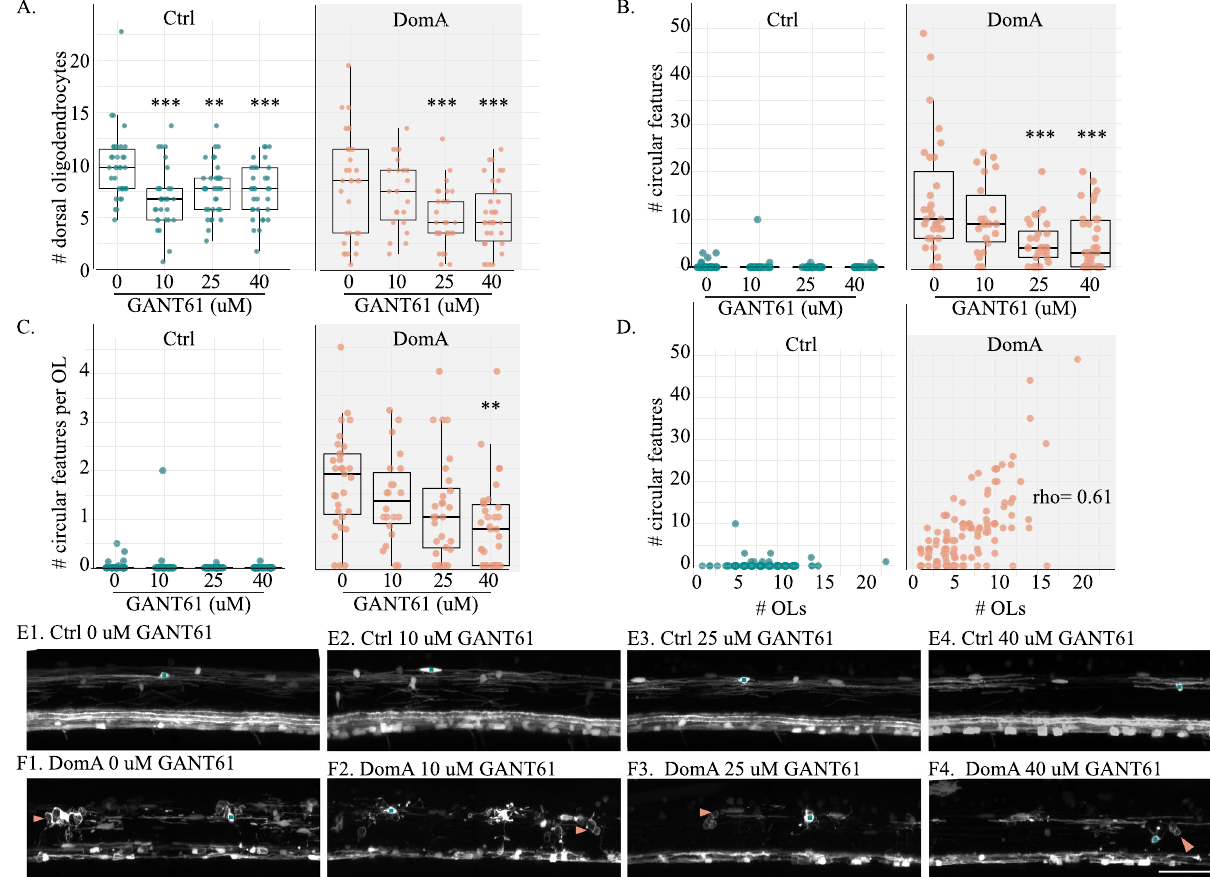
Figure 7. Treatment with GANT61, a small molecule that reduces the number of myelinating oligodendrocytes, also reduces the number of circular profiles in DomA treated fish. ( A ) Tg(mbp:EGFP) × Tg(mbp:EGFP-CAAX) double transgenic fish were exposed to DomA (0.14 ng) or vehicle at 2 dpf. Myelinating oligodendrocytes in the dorsal spinal cord were counted for control and DomA-exposed fish that were exposed to different concentrations of GANT61 (1.5- 4 dpf). Each point represents the number of oligodendrocytes counted within a 269 μM imaging area in a single fish. ( B ) Number of circular features in dorsal spinal cord of the same control and DomA exposed fish plotted in ( A ). ( C ) The number of circular features per oligodendrocyte (OL) in the dorsal spinal cord of the control and DomA-exposed fish that were exposed to different concentrations of GANT61. ( D ) The number of circular features plotted against the number of dorsal OLs. ( E ) Images of control fish exposed to 0 μM (E1), 10 μM (E2), 25 μM (E3), and 40 μM GANT61 (E4). ( F ) Images of DomA fish exposed to 0 μM (F1), 10 μM (F2), 25 μM (F3), and 40 μM GANT61 (F4). Scale bar = 50 μm.* = p < 0.05, ** = p < 0.01, *** p < 0.001 by generalized mixed models with a Poisson or a negative binomial distribution. Teal asterisks label oligodendrocyte cell bodies. Peach arrows point to circular features. Data were aggregated from two trials. See Supplemental Fig. 4 for data from individual